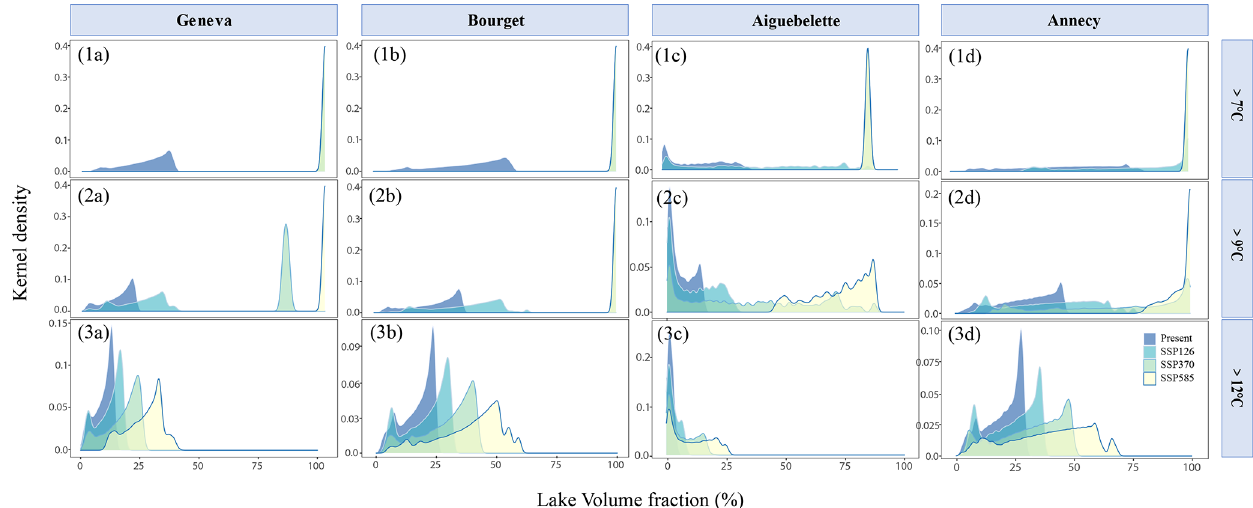
Figure 8. Lake volume fraction with temperature exceeding three characteristics’ thresholds – 7 ◦ C (1), 9 ◦ C (2), and 12 ◦ C (3) – calcu- lated from simulated water temperature profile and bathymetry in Lake Geneva (a) , Bourget (b) , Aiguebelette (c) , and Annecy (d) . Kernel density estimates of daily average lake volume fraction over the present (2000–2010) and the future (2090–2100) predicted by the three scenarios (SSP126, SSP370, and